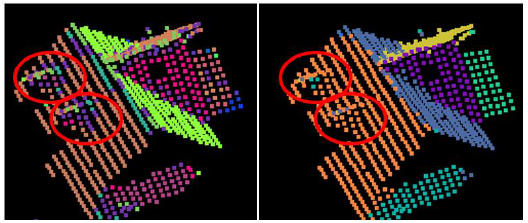
Figure 8. Example of a partially failed case of roof plane segmentation in the Vaihingen dataset due to the scale of the detail to be preserved. Left: Initial watershed segmentation result. Right: Final segmentation after GCO optimization.